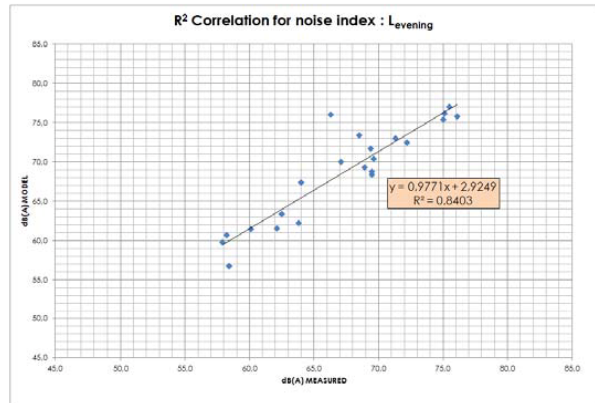
Figure 4: R 2 Correlation for noise index: L